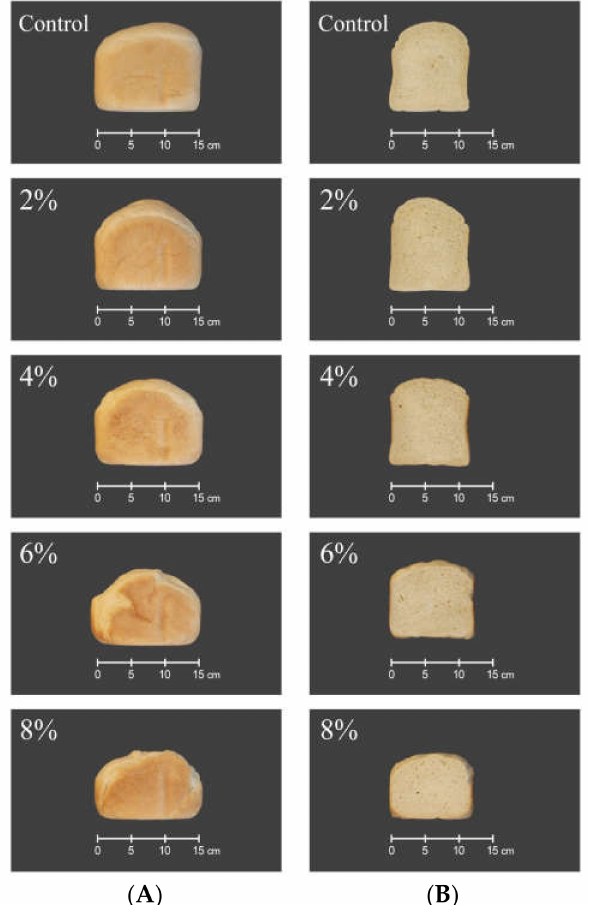
Figure 1. The effects of partially substituting high-gluten flour with soy protein isolate on the external appearance and cross-section of bread. ( A ) External appearance. ( B ) Cross section. Table 2. Effects of partially substituting high-gluten flour with soy protein isolate on the volume, weight, and specific volume of bread.